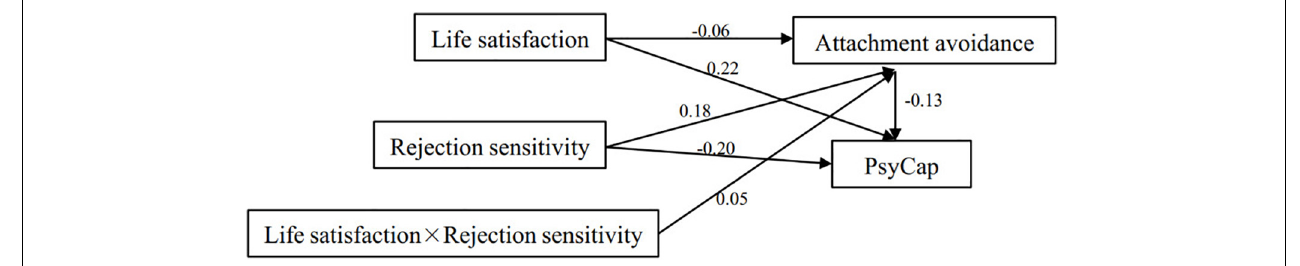
FIGURE 3 | The results of moderating mediating